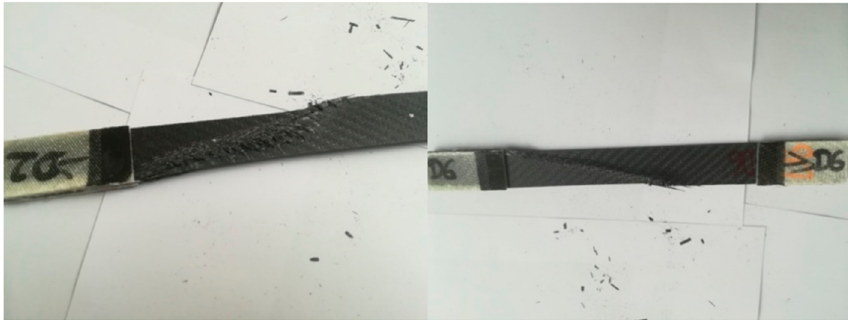
Figure 19. Appearance of samples from the D series after tensile bench testing.